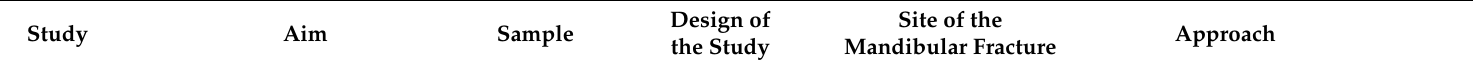
Table 2. Characteristics of the included